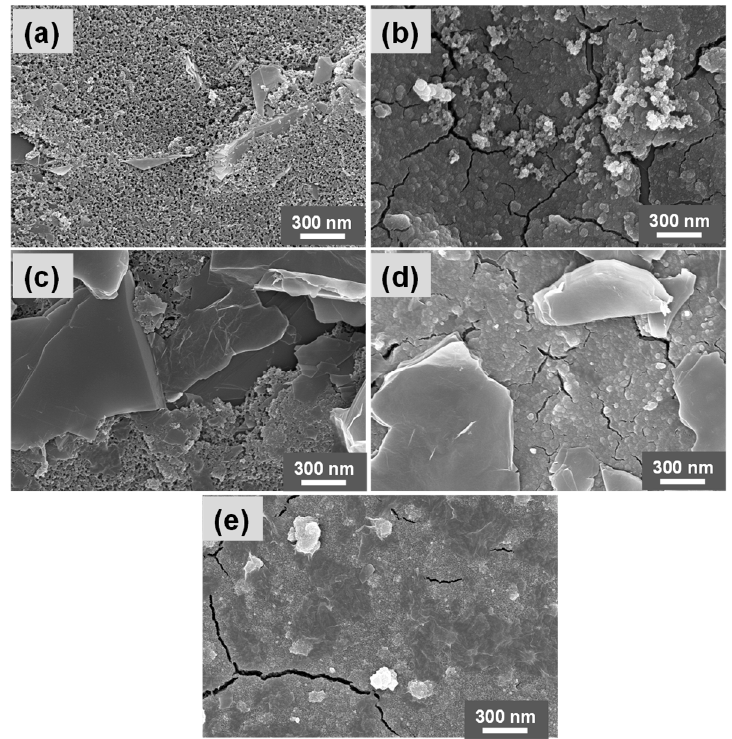
Figure 2. FE-SEM images of ( a ) bare SPCE, ( b ) PB/SPCE, ( c ) P-rGO/SPCE, ( d ) P-rGO/PB/SPCE, and ( e )